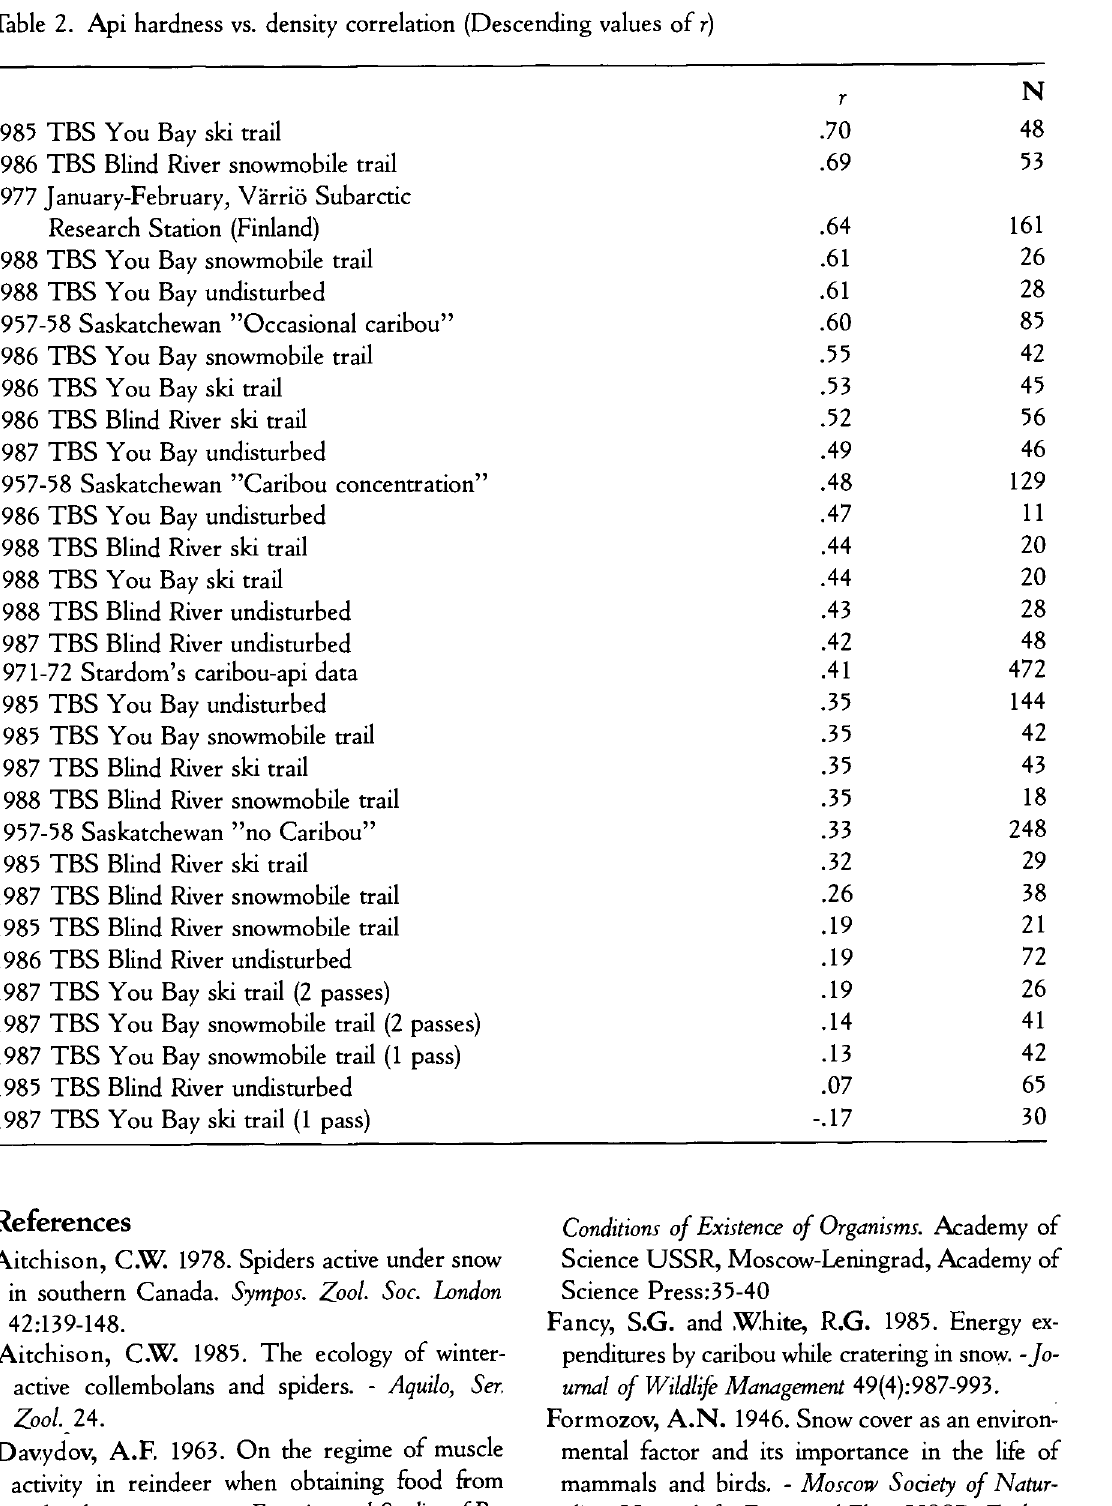
Table 2. Api hardness vs. density correlation (Descending values of r)